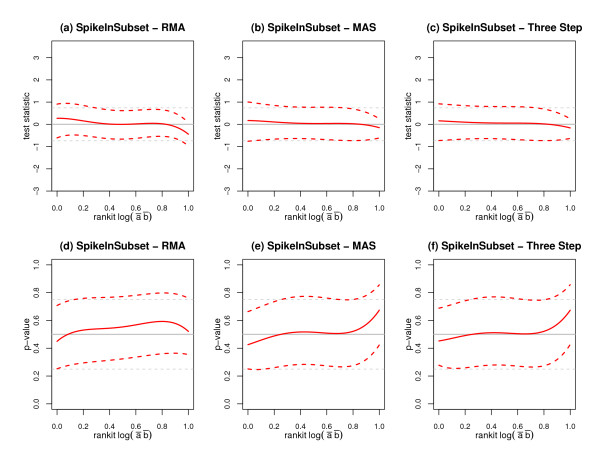
Estimates of the null t-statistic and p-value quartiles vary as a function of signal intensity for the Affymetrix SpikeInSubset dataset. The dataset was processed using Bioconductor implementations of the RMA, MAS, and three-step normalization functions. The x-axes correspond to the rankit (i.e., rank of valuetotal#of values+1
 MathType@MTEF@5@5@+=feaafiart1ev1aaatCvAUfKttLearuWrP9MDH5MBPbIqV92AaeXatLxBI9gBaebbnrfifHhDYfgasaacH8akY=wiFfYdH8Gipec8Eeeu0xXdbba9frFj0=OqFfea0dXdd9vqai=hGuQ8kuc9pgc9s8qqaq=dirpe0xb9q8qiLsFr0=vr0=vr0dc8meaabaqaciaacaGaaeqabaqabeGadaaakeaadaWcaaqaaiabbkhaYjabbggaHjabb6gaUjabbUgaRjabbccaGiabb+gaVjabbAgaMjabbccaGiabbAha2jabbggaHjabbYgaSjabbwha1jabbwgaLbqaaiabbsha0jabb+gaVjabbsha0jabbggaHjabbYgaSjabcocaJiabb+gaVjabbAgaMjabbccaGiabbAha2jabbggaHjabbYgaSjabbwha1jabbwgaLjabbohaZjabgUcaRiabigdaXaaaaaa@52A7@) of the log of the product of the expression means. The y-axes correspond to the observed t-test statistics and the observed two-sided p-values for the top and bottom rows, respectively. Solid and dashed grey lines indicate the theoretical medians and quartiles, respectively. The null p-values and t-statistics were modeled as a function of a 4th order polynomial for rankit intensity. Black and red lines correspond to the quantile regression fits for τ = 0.5 (solid) and τ = 0.25, 0.75 (dashed). The plots suggest that the null distributions may be intensity dependent, although not to the extent as was observed in the original Golden Spike datasets. Accurate quantification of the statistical significance associated with the observed intensity dependence requires an understanding of the underlying correlation structure across expression measures and remains an open research question.